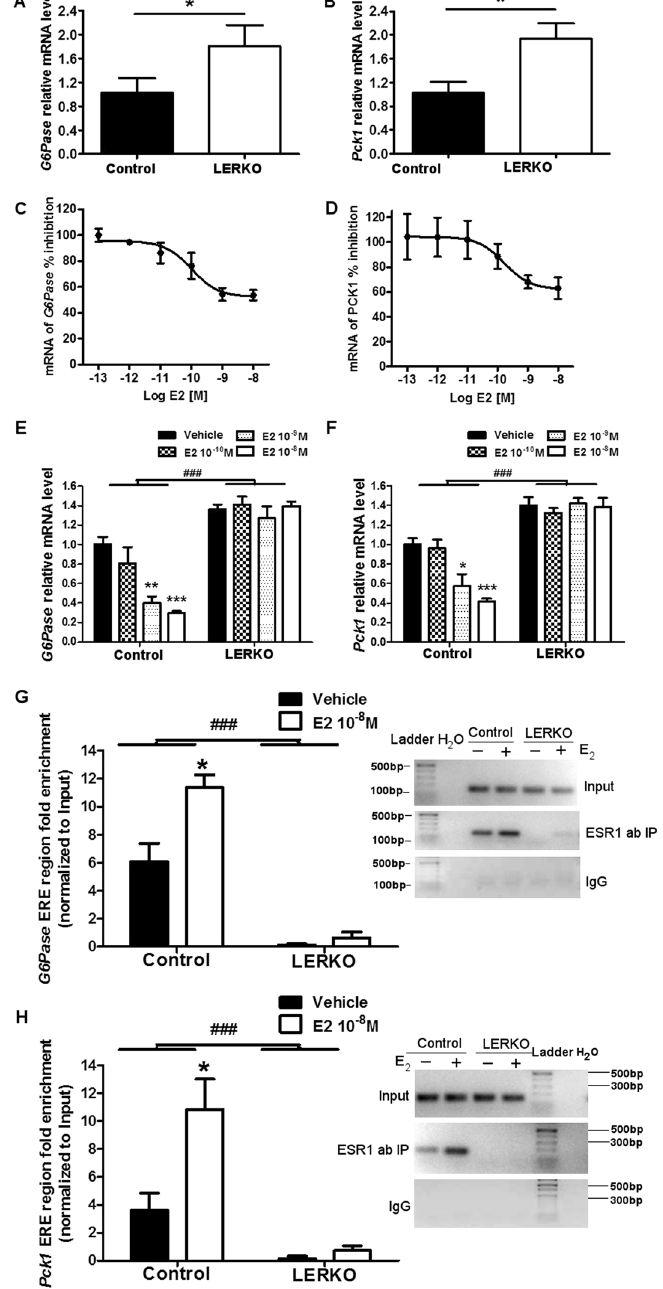
Figure 3. ESR1 inhibition of gluconeogenic gene expression is E 2 dependent. ( A , B ) Hepatic mRNA levels of G6Pase and Pck1 from Control mice and LERKO mice (n >= 6 per genotype). ( C , D ) Primary hepatocytes from Control mice were treated with vehicle or different doses of E 2 (10 − 12 M, 10 − 11 M, 10 − 10 M, 10 − 9 M, 10 − 8 M), mRNA levels of G6Pase and Pck1 were measured by q-RT-PCR. F-H, primary hepatocytes from Control and LERKO mice were treated with vehicle or different doses of E 2 (10 − 10 M, 10 − 9 M, 10 − 8 M), mRNA levels of G6Pase and Pck1 were measured by q-RT-PCR. ( E , F ) Primary hepatocytes from Control and LERKO mice were treated with vehicle or different doses of E 2 (10 − 10 M, 10 − 9 M, 10 − 8 M), mRNA levels of G6Pase and Pck1 were measured by q-RT-PCR.G-H, ChIP assay experiments were performed with liver tissues using antibody to ESR1, or with rabbit preimmune serum (IgG) and primers flanking the G6Pase ( G ) and Pck1 ( H ) promoters. Real-time PCR data with an inset of a 1.5% agarose gel as a representative example. Results were normalized to input and shown as fold enrichment IgG from 3 independent ChIP experiments. The experiments were performed 2 weeks after virus injection. The data are expressed as the means ± SD, * p < 0.05 versus control, * p < 0.05 versus vehicle, ### p < 0.001 versus